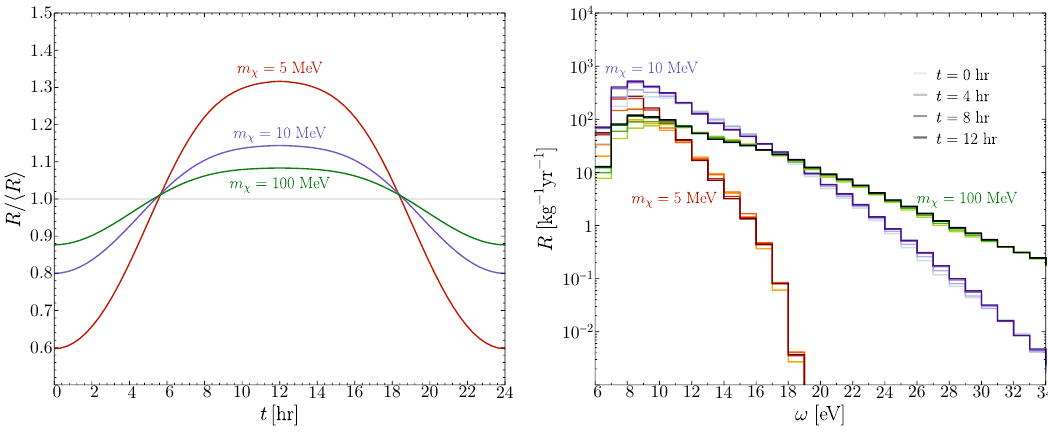
Figure 3 . Total rate of electron transitions R in hexagonal BN, normalized to its daily average h R i as a function of time (left), and di(cid:11)erential rates at several times of the day assuming (cid:27) e = 10 (cid:0) 37 cm 2 (right), for a 5 ; 10 ; 100 MeV DM scattering via a light